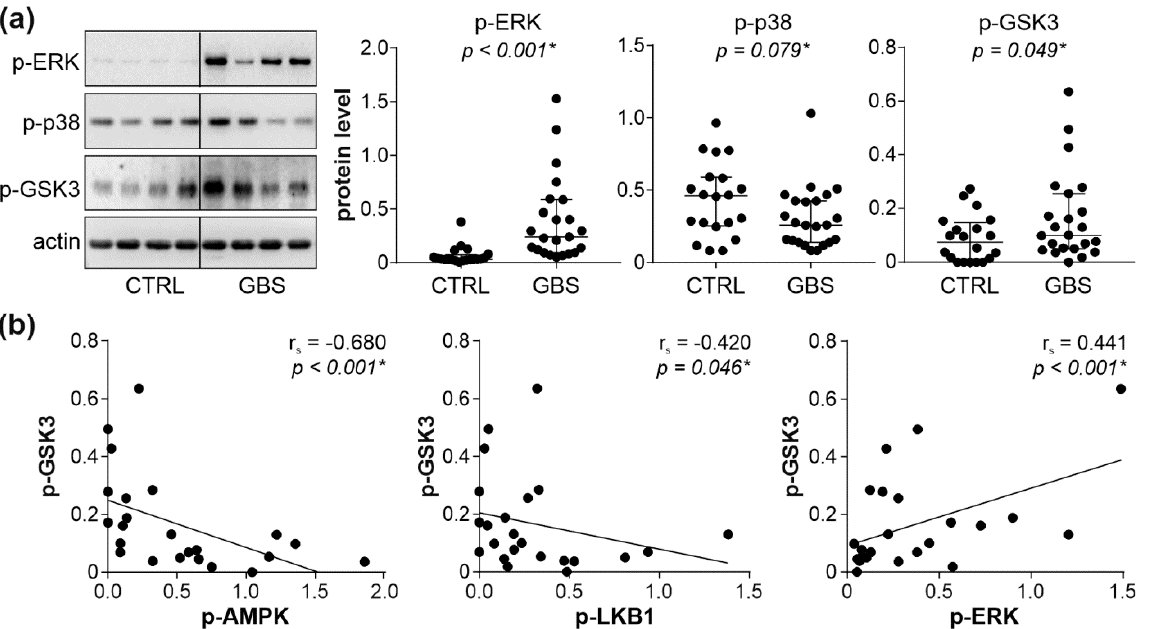
Figure 3. AMPK–ERK–PKC interplay in GBS PBMCs. ( a , b ) PBMCs were isolated from control subjects (CTRL; n = 20) and GBS patients ( n = 23), and the levels of phosphorylated ERK, p38 MAPK, and GSK3 β were assessed by immunoblotting. The representative blots and densitometry data (relative to actin) are shown in ( a ), with horizontal lines representing median values and interquartile range (* p < 0.05, two-tailed Mann–Whitney U test). The correlations between GSK3 β and phospho- AMPK, phospho-LKB1, or phospho-ERK are presented in ( b ) (r s —Spearman’s correlation coefficient; * p < 0.05, Spearman’s rank-order test).